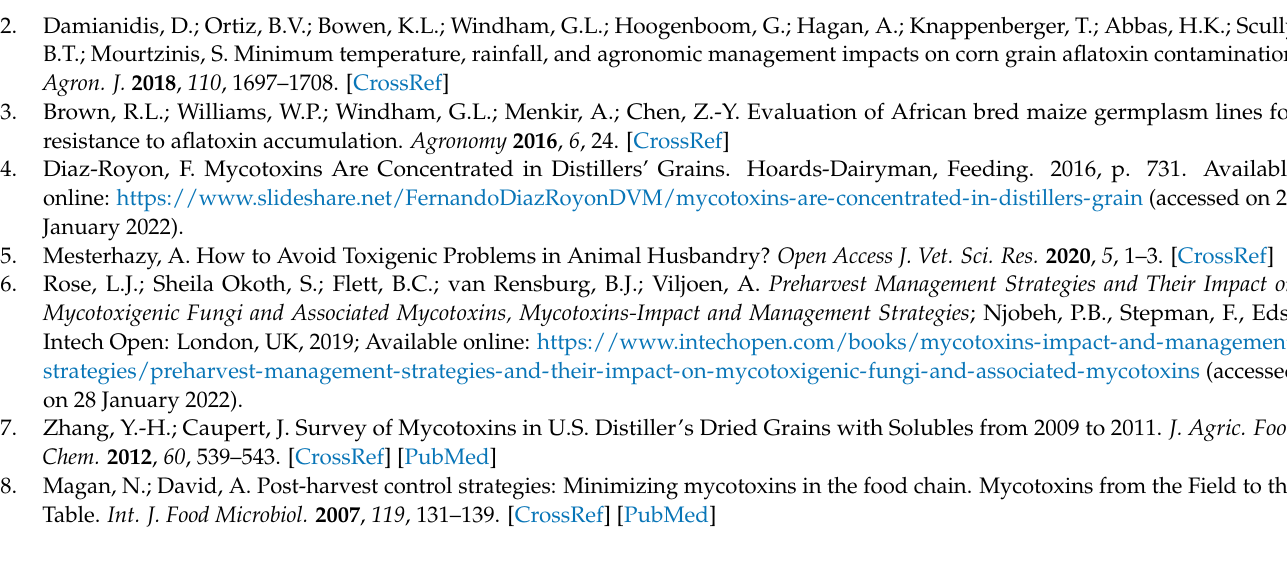
Table. Int. J. Food Microbiol. 2007 , 119 , 131–139. [CrossRef]